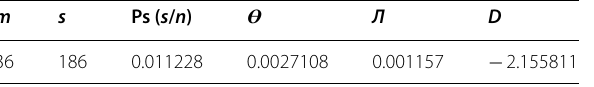
m number of samples, n total number of sites, s number of segregating sites, Ps s / n , ϴ Ps/a1, Л nucleotide diversity, D Tajima’s test statistic (Thomas 2001) Table 3 Comparison of Tajima’s neutrality test in Kurds in different studies Population